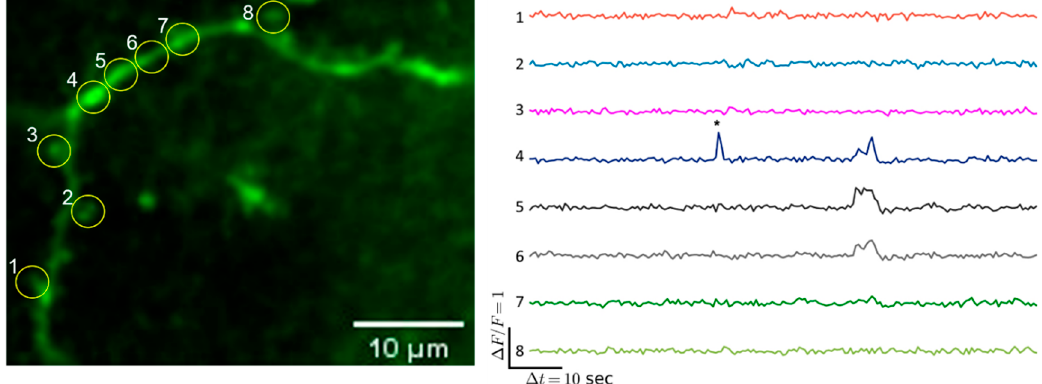
Figure 8. Example calcium traces in the dendritic spine of Fos-TRAPed PtA neuron. Yellow circles are regions of interest. We registered calcium event in ROI 4 and the following fluorescence increase in the neighboring ROIs 5 and 6 of the dendritic shaft. Asterisks * mark calcium events.